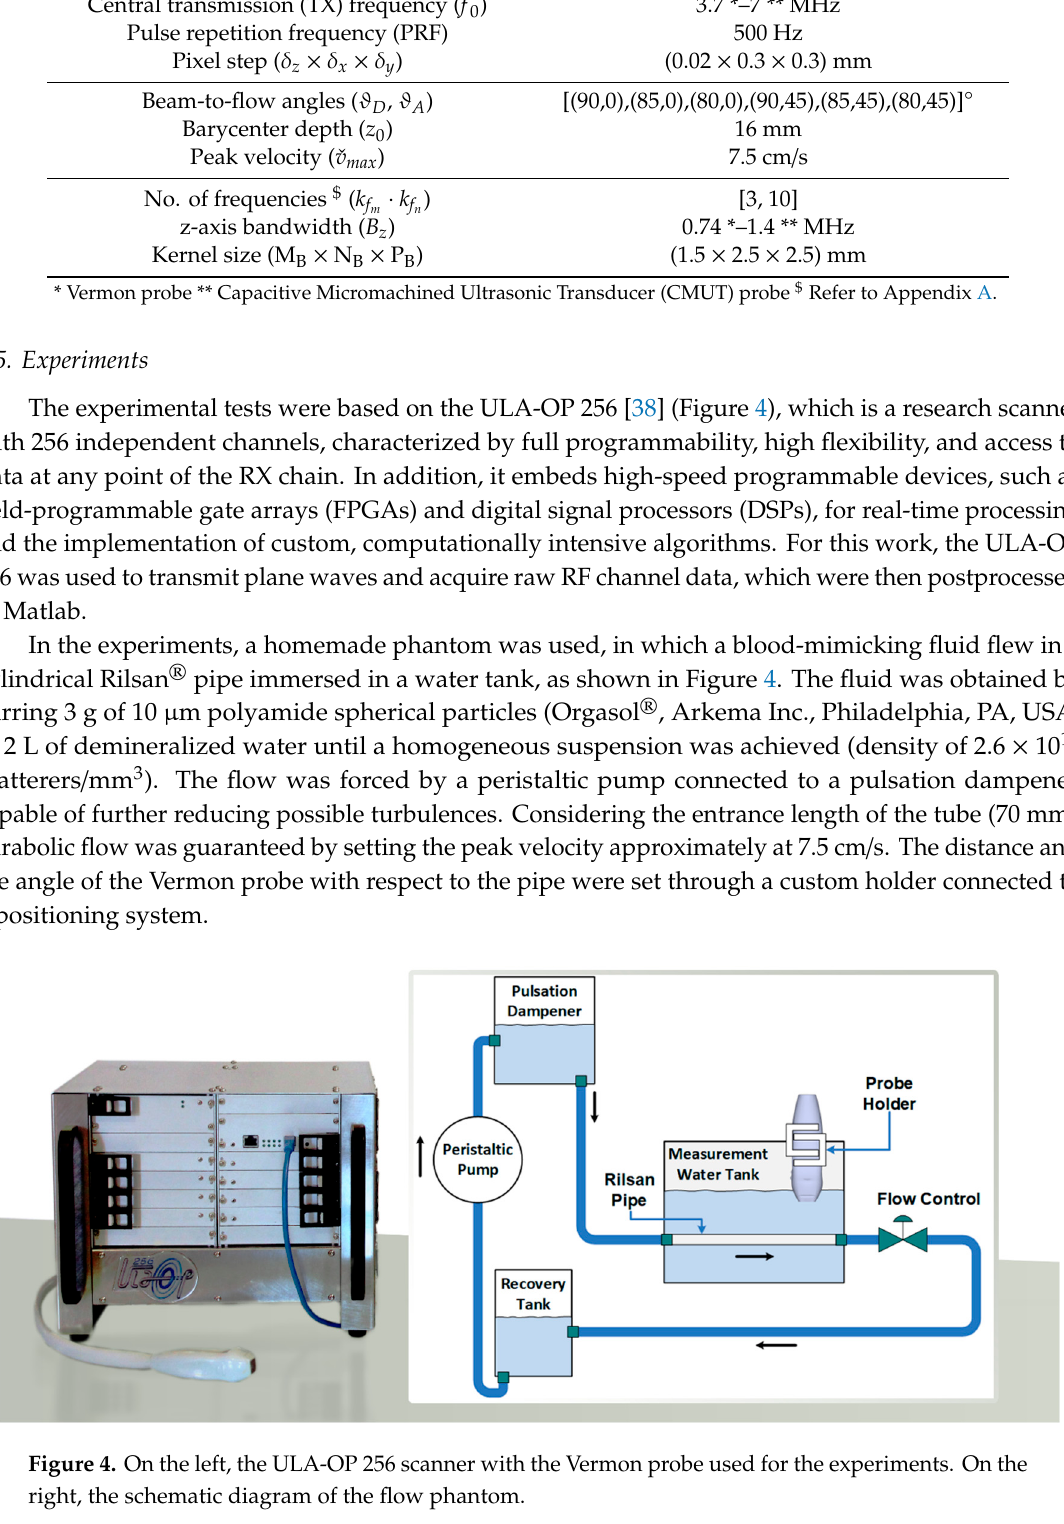
Table 1. Imaging, flow, and processing parameters.